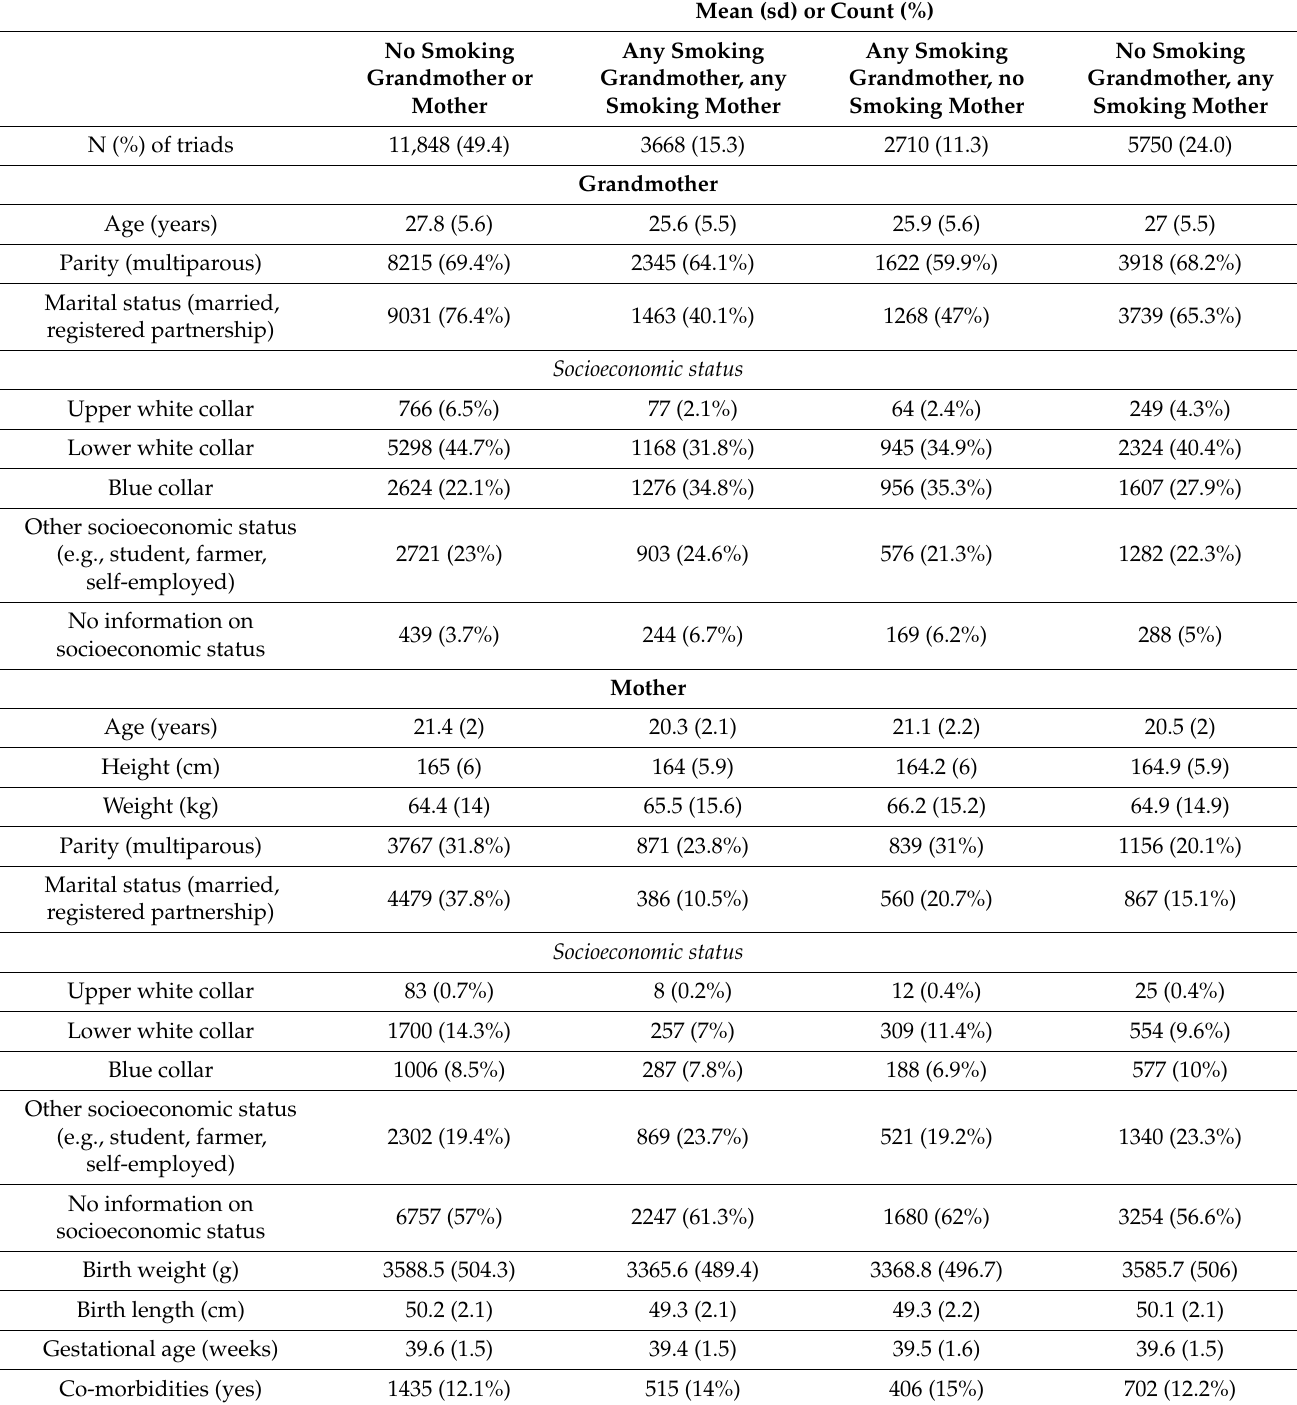
Table 4. Description of the study